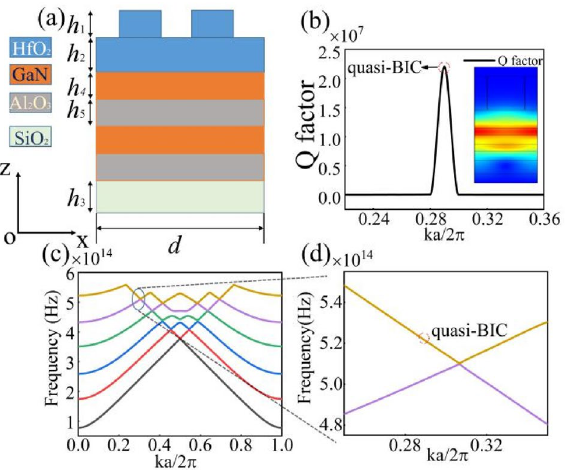
Figure 6. ( a ) Schematic showing the complex structure considered here that is made up of grating and multilayers substructures. ( b ) Q factor of this structure was found to be over 107 and the normalized electric field is shown in the inset. ( c ) The energy bands of the hybrid structure with the point of the quasi-BIC indicated near the first crossing point. ( d ) The point of the BIC is located at a ka/2π value between 0.28 and 0.32.